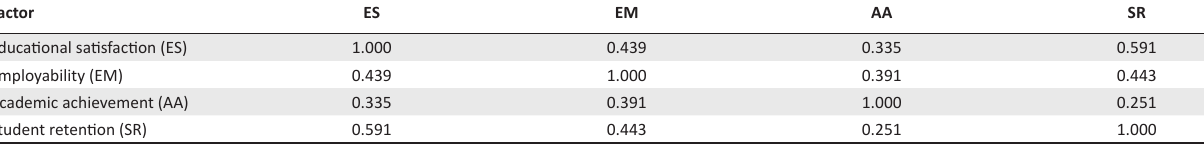
TABLE 7: Factor correlation matrix for student educational outcomes effectiveness questionnaire.